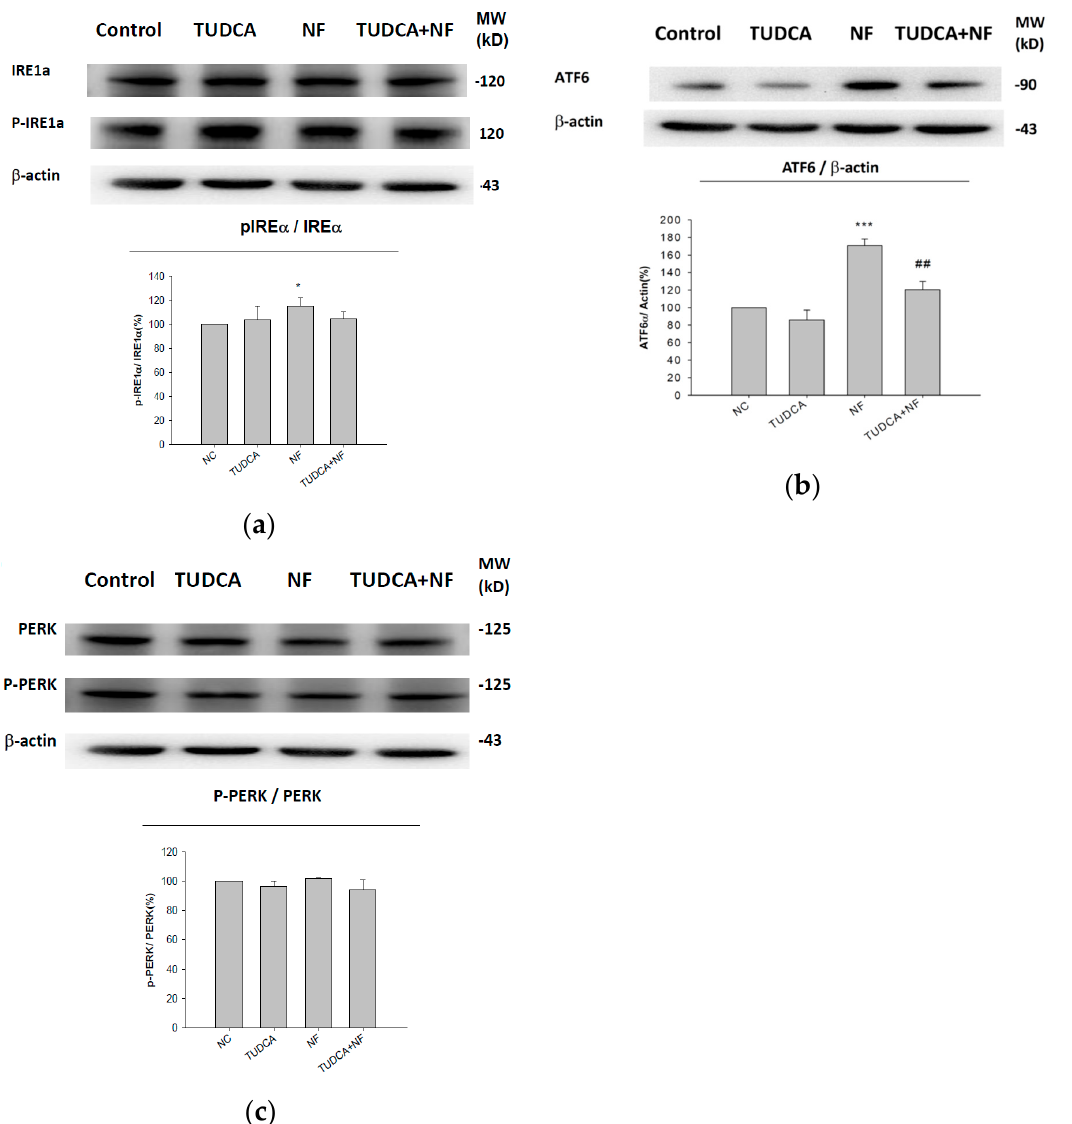
Figure 4. Protective effect of tauroursodeoxycholic acid (TUDCA) against nifedipine (NF) in NRK52E cells. Representative Western blots of ( a ) inositol-requiring enzyme 1 α (IRE1 α ), phosphorylated (p)-IRE1 α , ( b ) activating transcription factor 6 α (ATF6 α ), ( c ) protein kinase RNA-like ER kinase (PERK), and p-PERK signal proteins. β -actin was used as the constitutive protein control. * P < 0.1, ** P < 0.05, *** P < 0.01 compared to normal control; ## P < 0.05 compared to NF group ( n = 3). 2.5. Early Apoptosis of NRK52E Cells Induced by NF May Partially Be due to Activation of Caspase-3 and